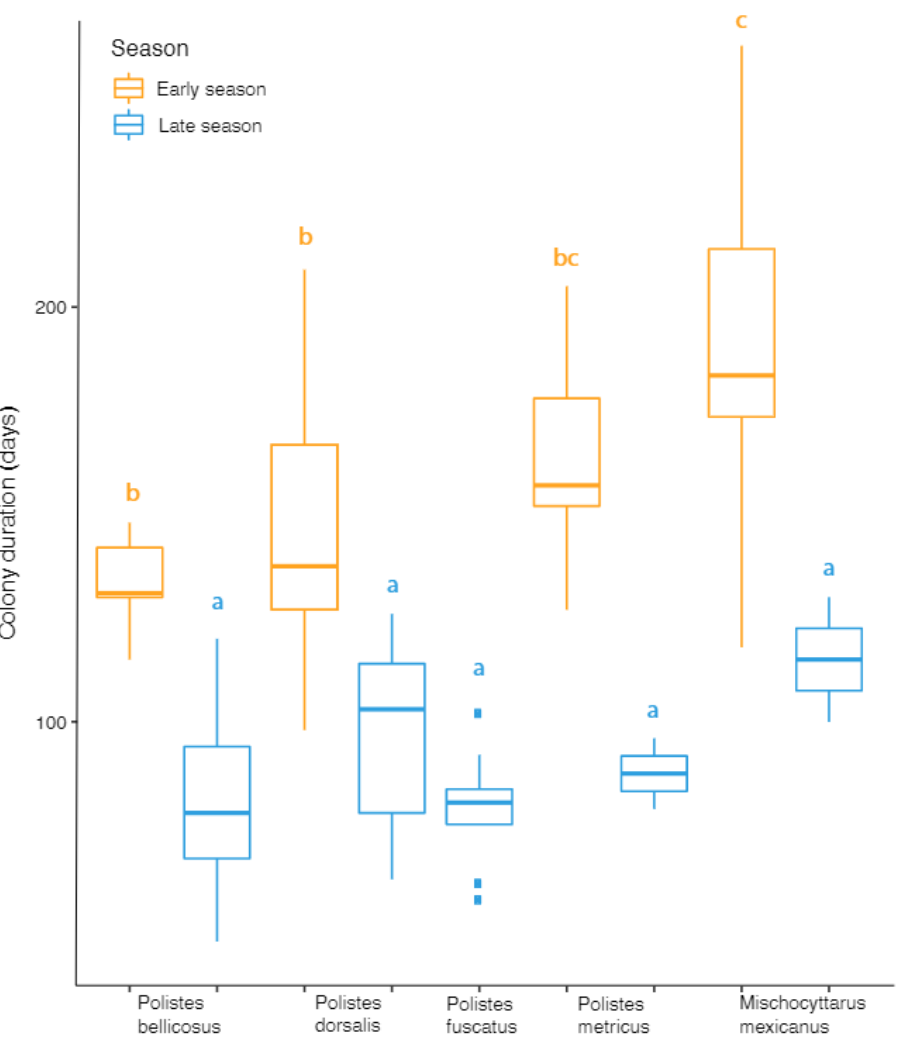
Figure 3. Colony duration (number of days devoted to brood rearing) for five polistine species.in early and late season nests. Lettering above shows differences based on multiple pairwise comparisons among species across each season.